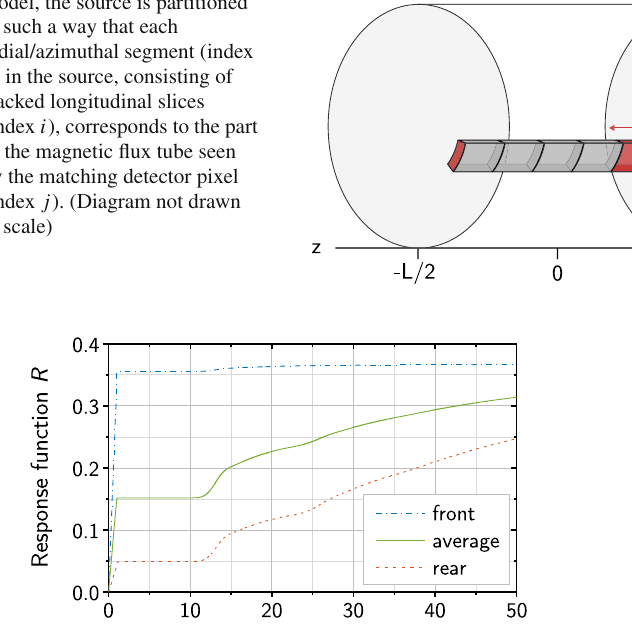
Fig. 10 In the numerical model, the source is partitioned in such a way that each radial/azimuthal segment (index j ) in the source, consisting of stacked longitudinal slices (index i ), corresponds to the part of the magnetic flux tube seen by the matching detector pixel (index j ). (Diagram not drawn to scale)